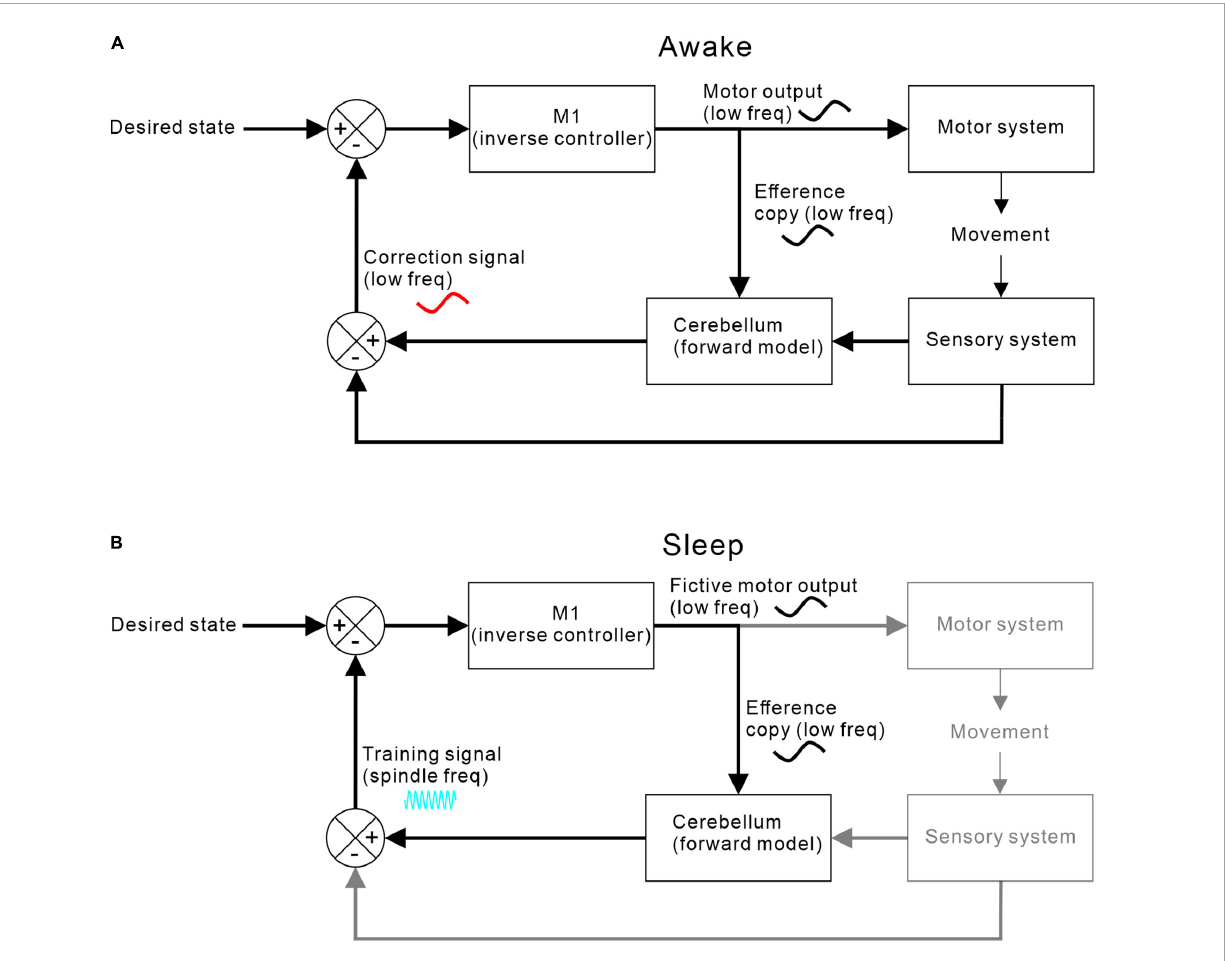
FIGURE5 M1-cerebellar functional coupling. (A) Coupling during waking when M1 efference copy of motor commands and cerebellar correction signals are both at movement-related low frequencies. (B) Coupling during sleep when no movements or sensory feedbacks occur but low frequency fictive motor commands continue to be sent to the cerebellum, which then returns a training signal at spindle-band